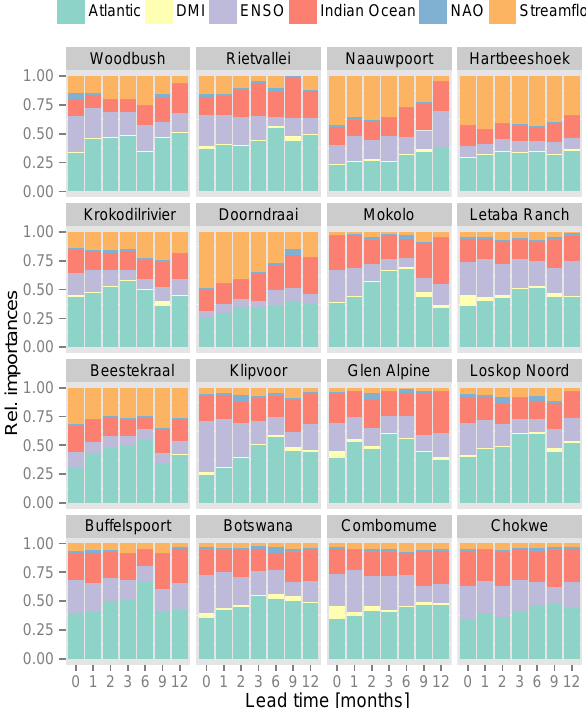
Figure 9. Relative importance of predictors in the RFOR mod- els grouped as follows: antecedent streamflow conditions, Indian Ocean dipole mode index (DMI), El Niño–Southern Oscillation (ENSO) indices, North Atlantic Oscillation index (NAO) and the customised indices of the southern hemispheric Atlantic (Atlantic) and the Indian Ocean (Indian Ocean). Stations are ordered increas- ingly by catchment area from small (top left) to large (bottom